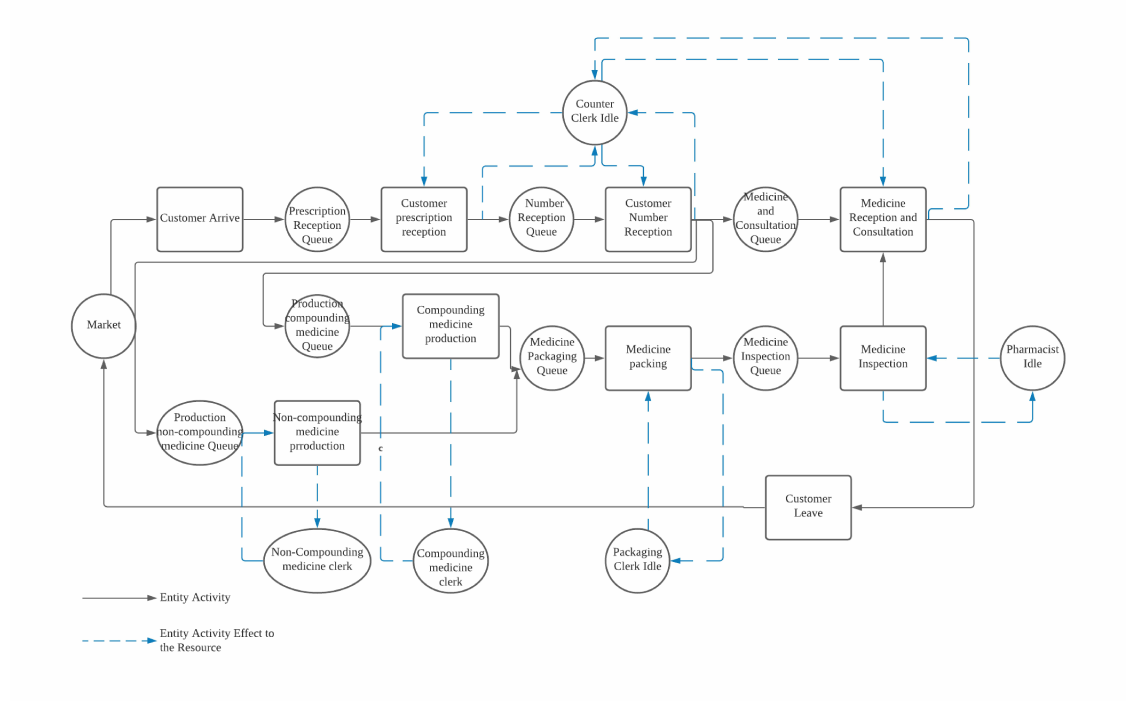
Fig. 4 Conceptual Model in the